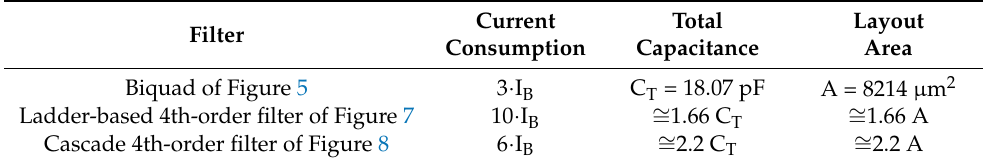
Table 2. Scalable properties of the developed 0.4-V, 100-Hz filters.